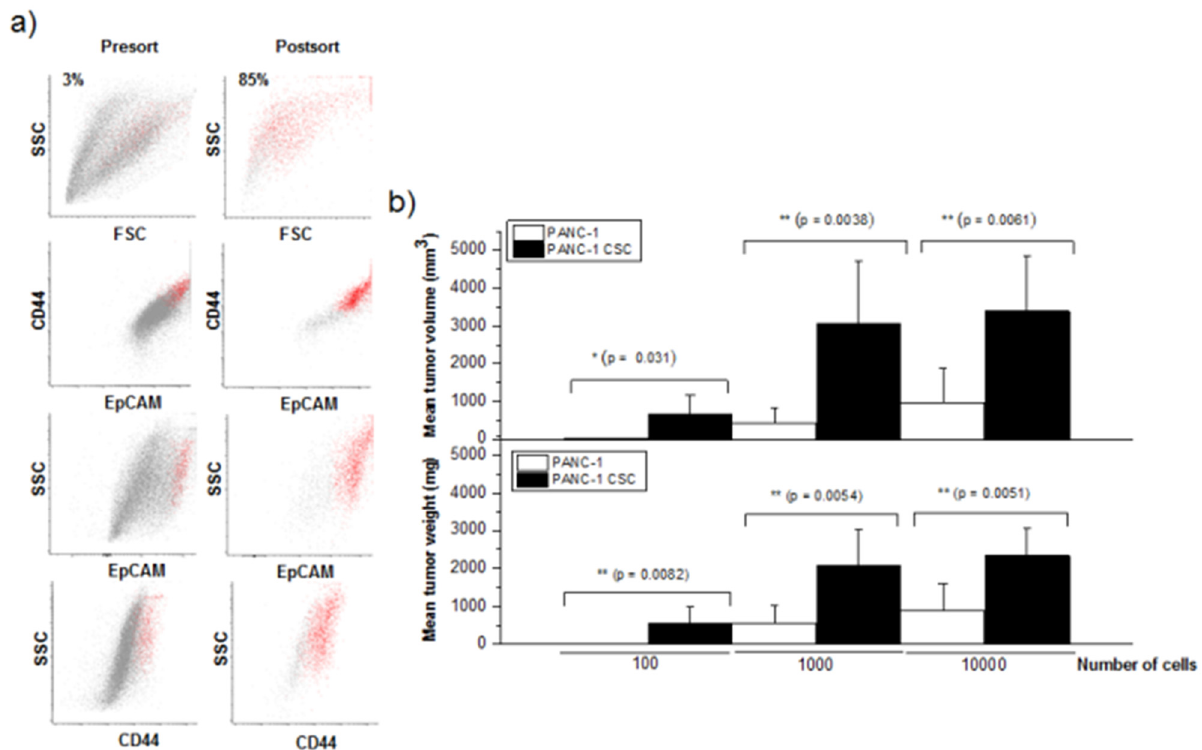
Figure 1. Sorting of pancreatic cancer stem cells and tumorigenic activity. ( a ) Following disaggregation of PANC-1-derived pancreatic cancer spheres, CD44 + CD24 + EpCAM + CSCs were purified by means of flow cytometry sorting as described in the Section 2. The percentage of the cells corresponding to the CSC population is indicated in the pre-sorting (Presort) and post-sorting (Postsort) histograms. ( b ) In immunodeficient mice, 10 2 , 10 3 and 10 4 PANC-1 cells and freshly sorted CD44 + CD24 + EpCAM + PANC-1 CSCs were injected, and tumor development was ana- lyzed after 4 months. Following 17 weeks, the animals were sacrificed and the weight and volume of each tumor gener-